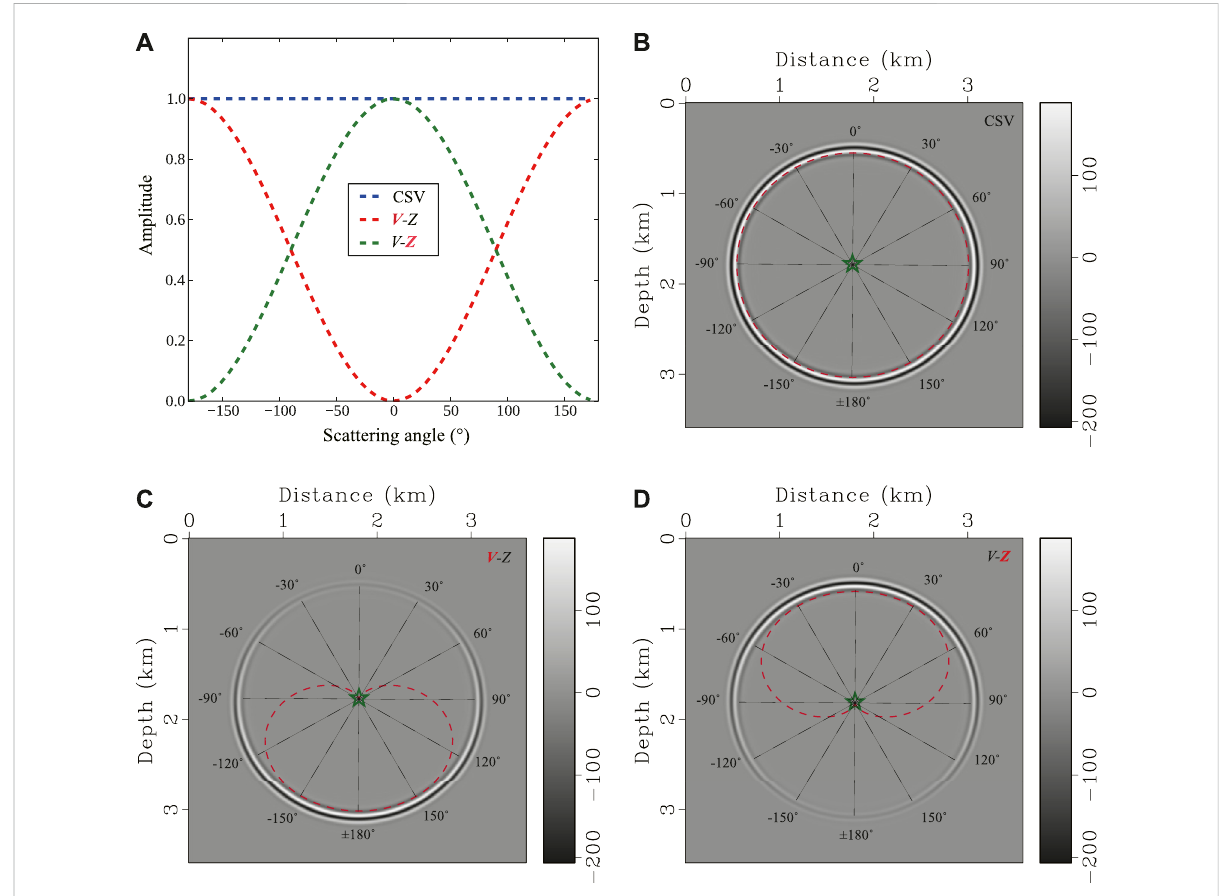
FIGURE 2 Scattering angle fi lters and radiation patterns for a vertically incident plane wave in a homogenous medium with v =2 km/s (A) Angle fi lters for different kernels; (B) CSV radiation pattern; (C) velocity and (D) impedance radiation patterns. A unit model perturbation indicated by a green star is located at x =2 km and z =2 km. Red dashed lines in (B) , (C) and (D) denote the amplitude variations with respect to different scattering